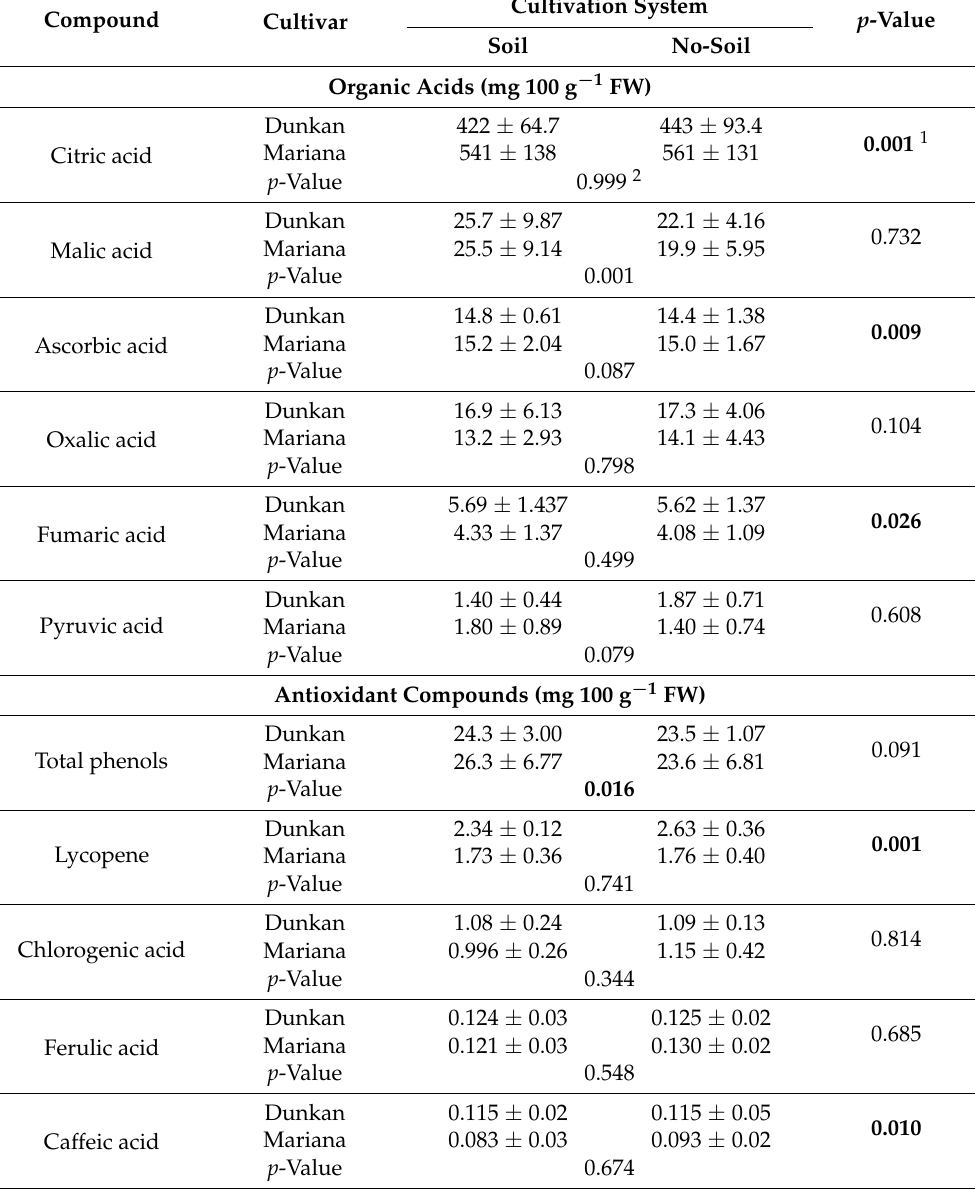
Table 2. Organic acids and antioxidant compounds composition (mean ± standard deviation, data expressed in fresh weight, FW) of tomato samples grouped according to cultivar and cultivation